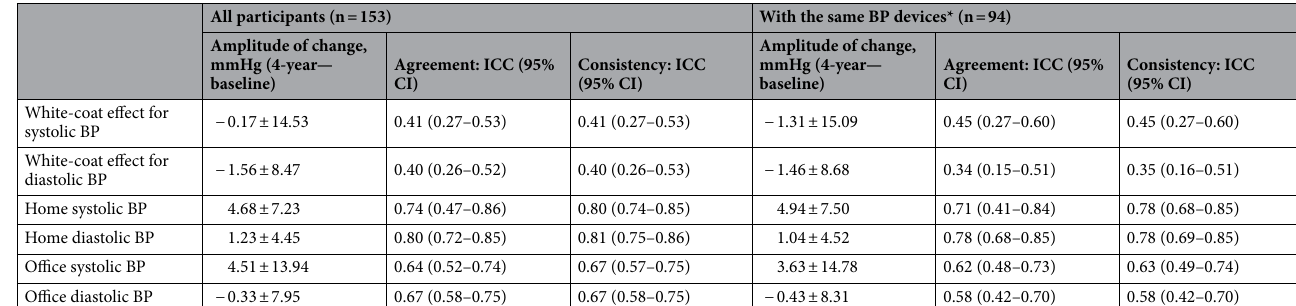
Table 3. Reproducibility of the white coat effect and BP levels. Agreement and consistency were assessed by ICC from the two-way random effect model single measures (ICC [2, 1]) and two-way mixed effect model single measures (ICC [3, 1]), respectively. BP blood pressure, ICC intraclass correlation coefficient, CI confidence interval. *The participants who used HEM-747ICN for home BP measurements and HEM-907 for office BP measurements were included in this analysis.